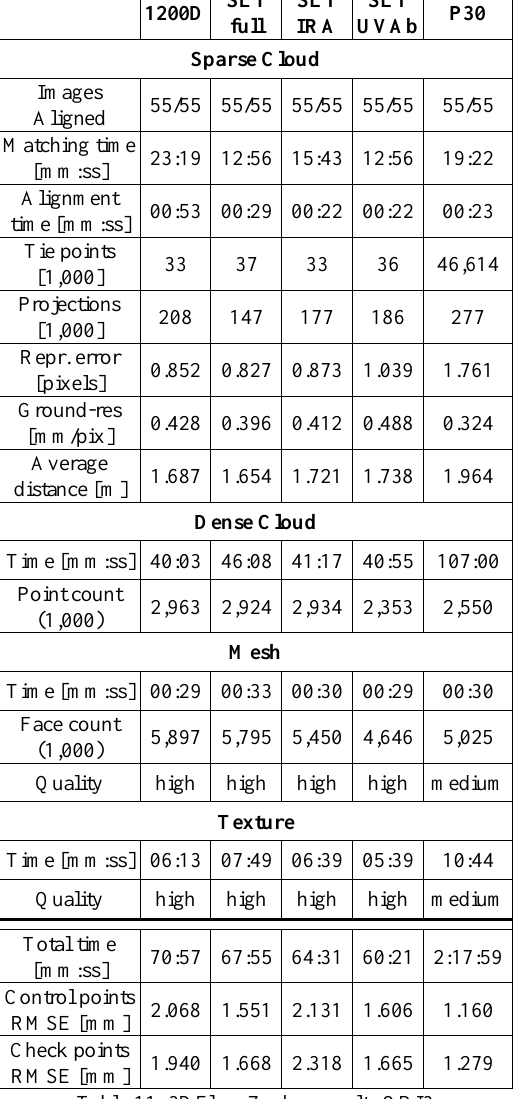
Table 11: 3DFlow Zephyr results OBJ3